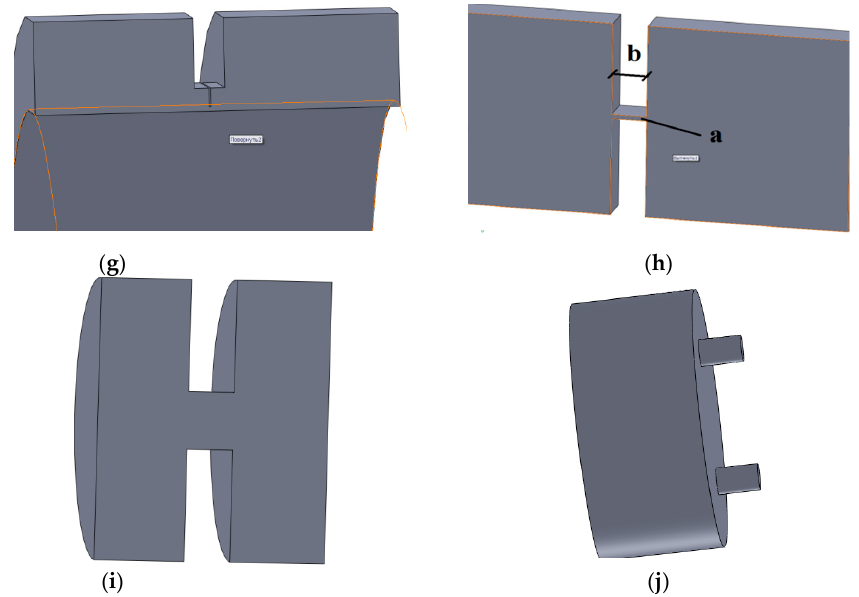
Figure 3. Seal models: ( a – g ) annular gap D = 240 mm, s = 0.225 mm; ( b ) r = 0.35 mm, 0.70 mm, and 1.59 mm; ( h ) flat slot ( a = 0.225 mm, b = 1.6 mm); ( i ) hole ( d = 2 mm, l = 1.6 mm); ( j ) two holes with d = 1 mm.